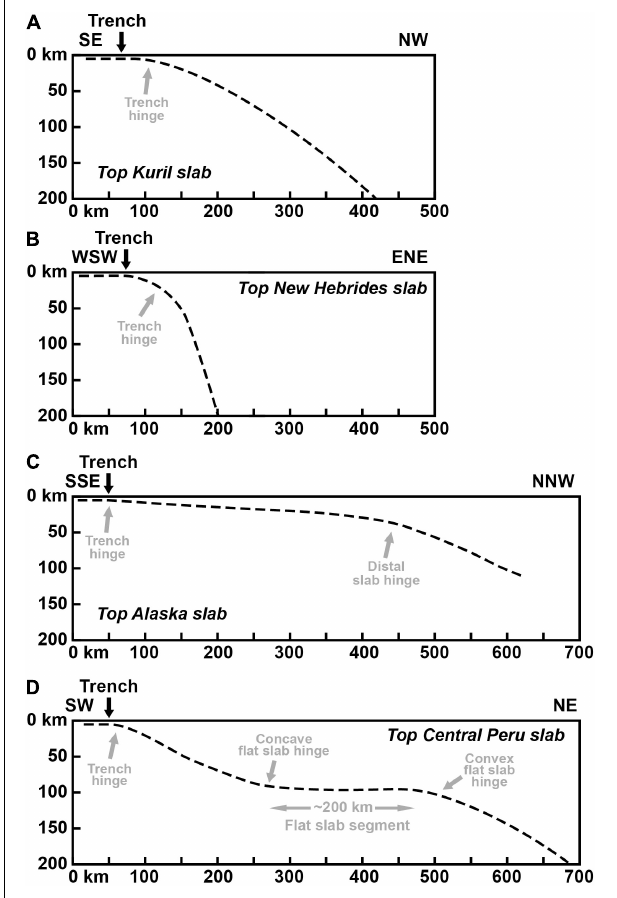
FIGURE 1 | Variability in geometry and dip angle of the uppermost ∼ 200 km of slabs in nature, as shown by four examples. (A) The southern Kuril slab segment as an example of normal subduction with one convex-upward slab hinge and a normal slab dip angle [geometry derived from Slab1.0 model (Hayes et al., 2012)]. (B) The southern New Hebrides slab segment as an example of normal subduction with one convex-upward slab hinge and a steep slab dip angle [geometry from Slab1.0 model (Hayes et al., 2012)]. (C) The Alaska slab segment as an example of unusual subduction with two convex-upward slab hinges and a low-dip-angle slab segment in between [geometry derived from Ohta et al. (2006)]. (D) The Central Peru slab segment as an example of unusual subduction with two convex-upward slab hinges (trench hinge and convex flat slab hinge) and one concave upward slab hinge (concave flat slab hinge) in between [geometry derived from Phillips and Clayton (2014)]. A (sub)horizontal slab segment is located between the concave and convex flat slab hinges. It is only this slab geometry with three hinges that is referred to as flat slab subduction in this work and that is the focus of this study. Note that all images show the geometry of the top of the